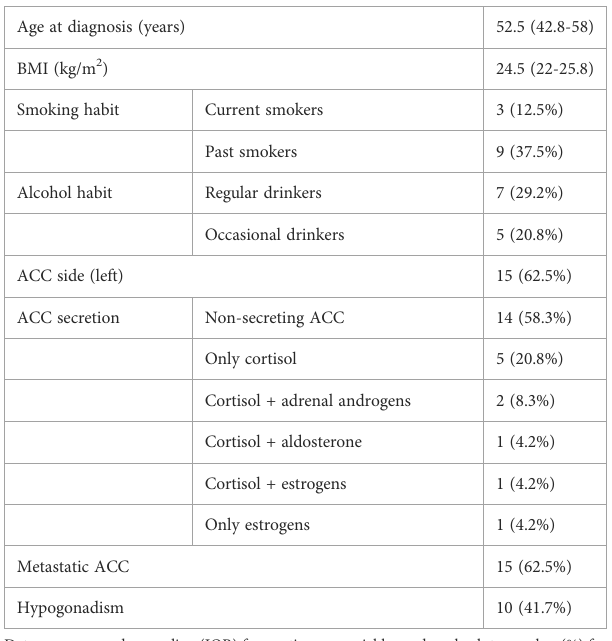
TABLE 1 Baseline characteristics of the included patients (n=24) prior to the start of